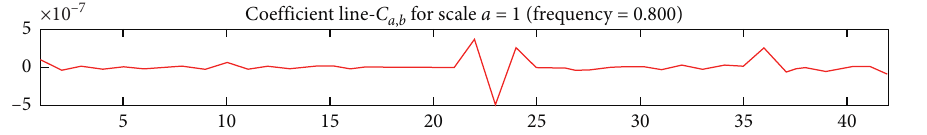
Figure 3: Wavelet coefficients.